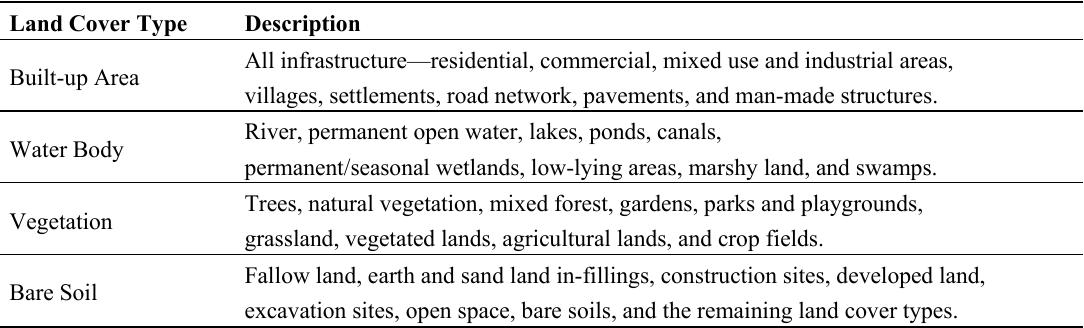
Table 2. Details of the land cover